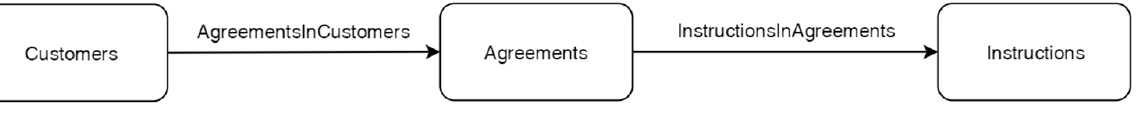
Figure 16. The target data model.